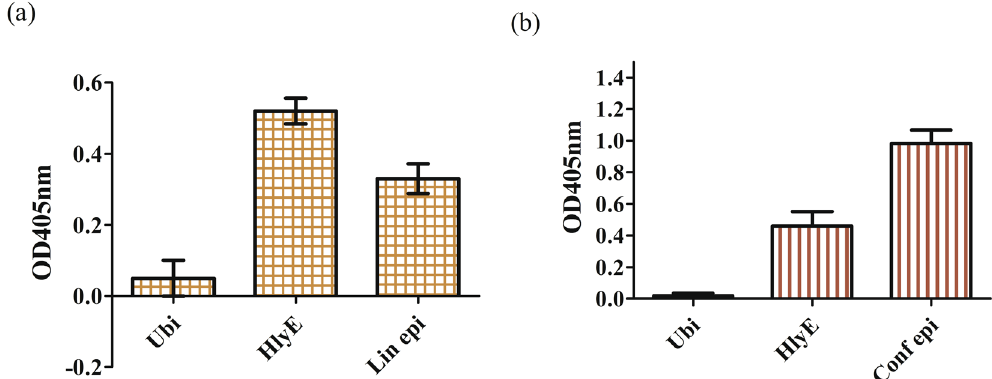
Figure 4. Soluble ELISA of mAbs against HlyE epitopes. ( a ) mAb_L_A11 and ( b ) mAb_C_C2 against ubiquitin, rHlyE and respective target epitopes with standard deviation shown in